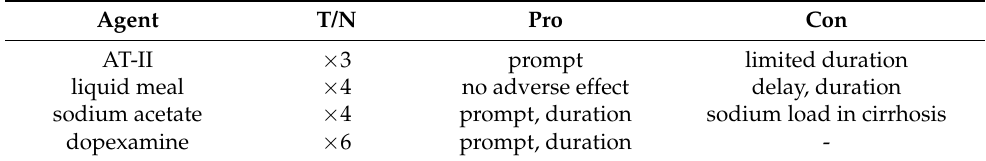
Table 3. Pros and cons of different